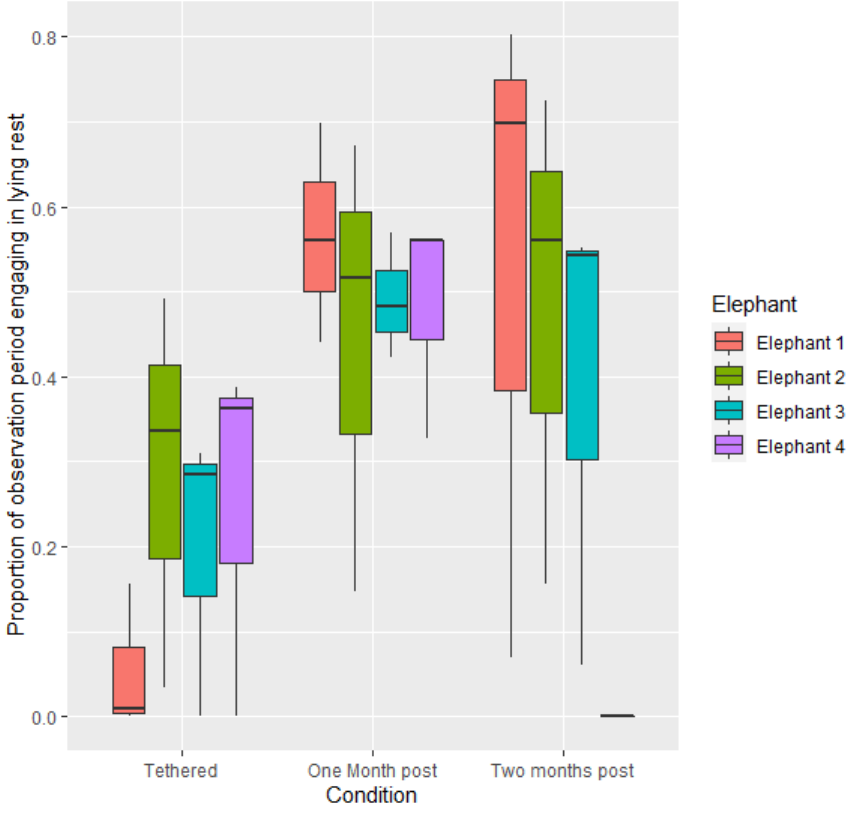
Figure 1. Mean proportion of time spent engaging in lying rest per observational period during the three conditions. Across all elephants, there was no difference between proportion of time spent en- gaging in standing rest when not tethered as compared to tethered ( p > 0.05). Proportion of time spent engaging in standing rest was greater two months post release from tethers than one-month post-release from tethers (1.231 ± 0.4275, z = 2.627, p < 0.05). There were no significant differences in proportion of time spent engaging in standing rest between elephants when they were on tethers or the first month post-release from tethers. In the second month post-release from tethers, E4 engaged in significantly more standing rest than when he was tethered ( − 3.3377 ± 0.780, p < 0.01) and in the first month post-release from tethers ( − 2.7386 ± 0.663, p < 0.01) (Figure 2). During the second month post-release from tethers, E4 also engaged in greater proportions of standing rest per night than E1 ( − 2.5290 ± 0.633, p < 0.01), E2 ( − 2.1226 ± 0.590, p < 0.05) and E3 ( − 2.3672 ± 0.614, p < 0.01). Across all elephants, there was a negative correlation between proportion of time spent in standing rest versus lying rest (R s = − 0.53, p < 0.001).